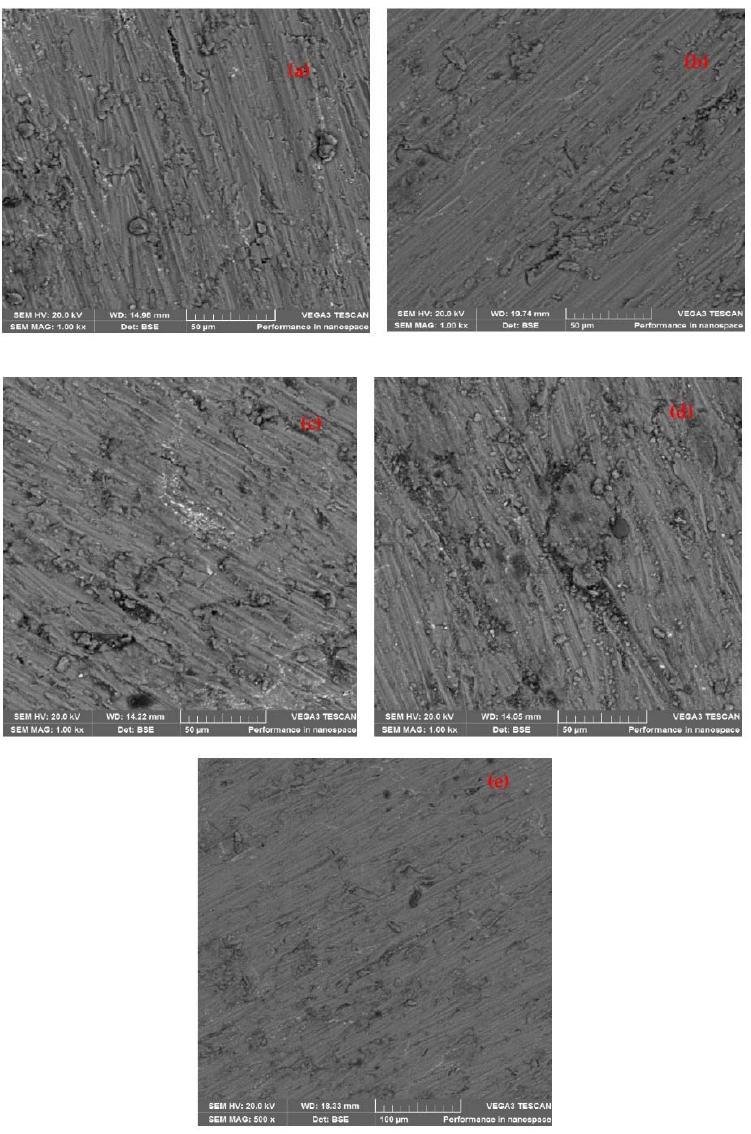
Figure 1. Scanning electron micrographs of ( a ) sample A0, ( b ) sample A1, ( c ) sample A5, ( d ) sample A6, ( e ) sample